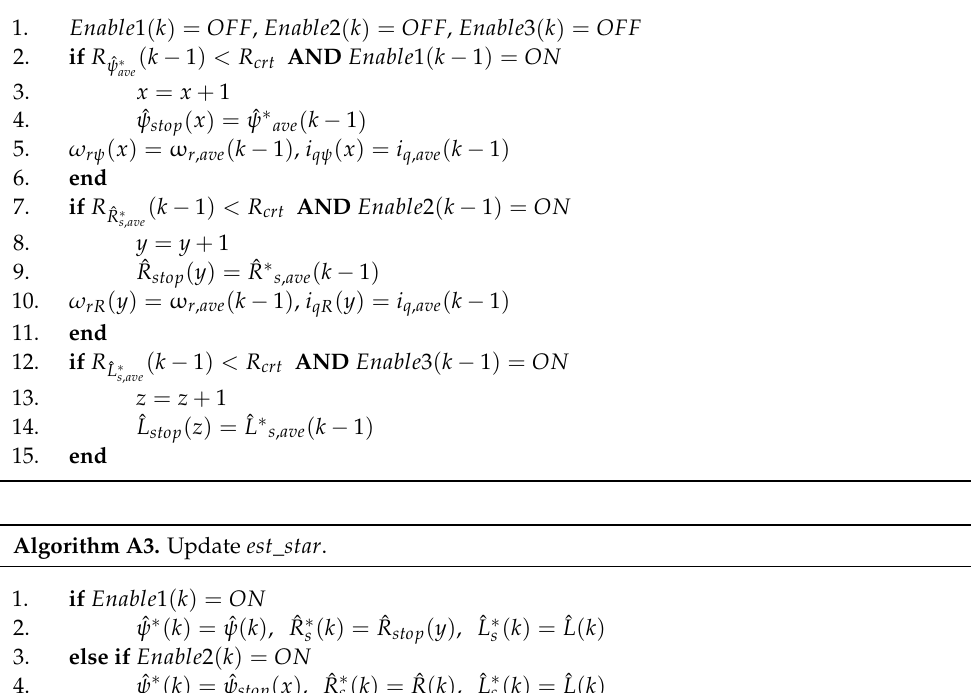
Algorithm A2. Estimations steady-state check and partial estimations update.